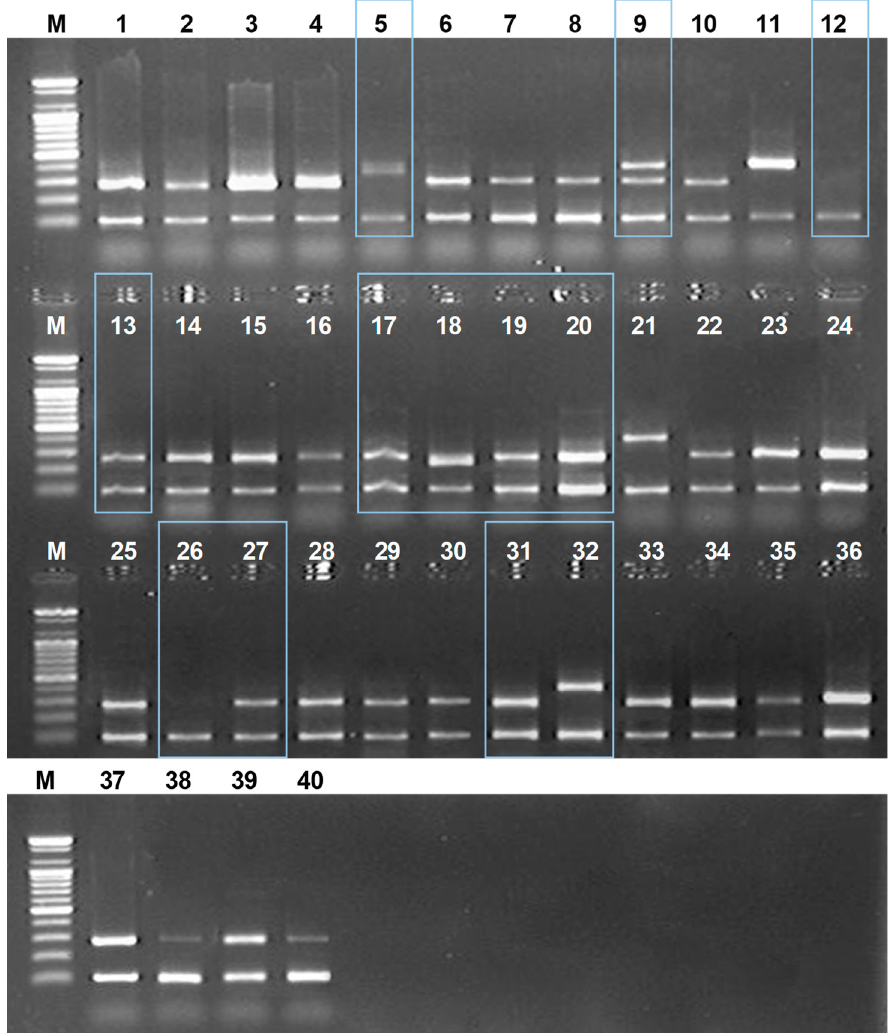
Figure 4. The monitoring results of commercial Amomi Fructus by using multiplex PCR with the designed AVF1/ISR/ISF/ALF1 primer set in this study. Lane numbers above: The sample number as listed in Table 2. M: 100 bases ladder; Box shows different amplified results than expected.